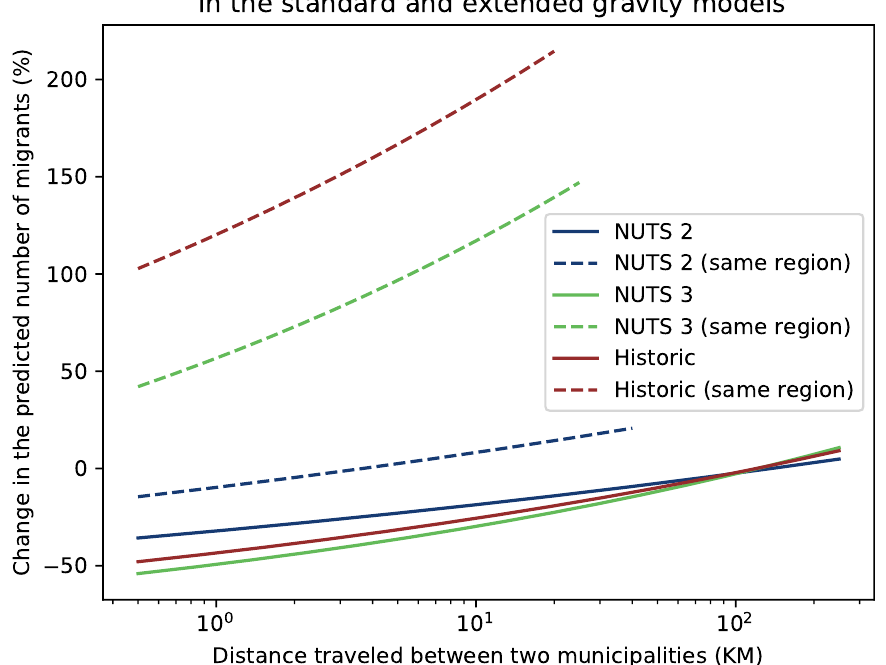
Figure 2. Difference between the expected number of migrants found in Equations (3) and (6)–(8). When two municipalities are located in the same identity region, the number of migrants in the basic gravity model is much lower than expected in the extended models, whereas this is the other way around for municipalities that are not located within the same region. The maximum distance travelled by migrants within the same region is cut to the reflect the size of the regions within each of the sets of